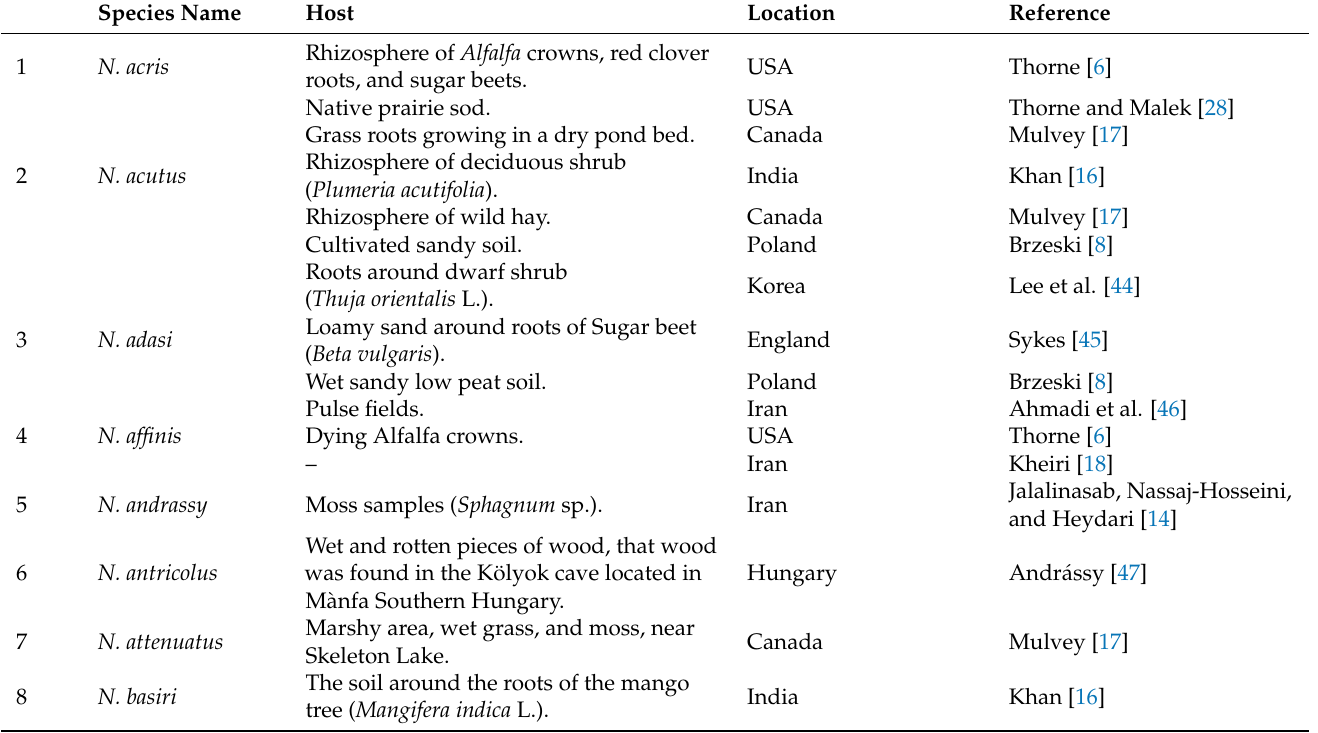
Abbreviations: n, number of specimens on which measurements are based; a, body length/greatest body diameter; b, body length/distance from anterior end to pharyngo-intestinal junction; c, body length/tail length; c’, tail length/tail diameter at anus; MB, distance between the anterior end of the body and center of the median pharyngeal bulb expressed as percentage (%) of the pharynx length; V, distance from the body anterior end to the vulva expressed as a percentage (%) of the body length. Table 3. Host association and distribution of nominal Nothotylenchus